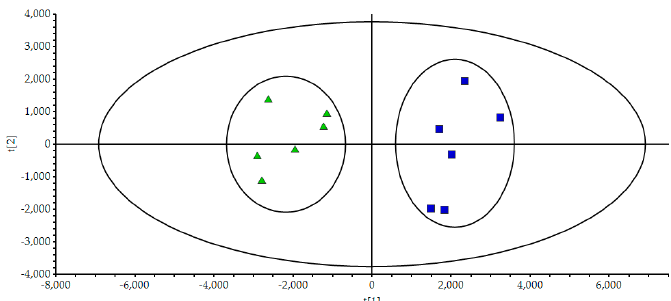
Figure 3. Score scatter plot of PCA processed data acquired from wild and cultivated wuweizi scanned by both positive and negative ion modes. Each of the green triangles represent a batch of wild wuweizi, while the blue squares represent a batch of cultivated ones.